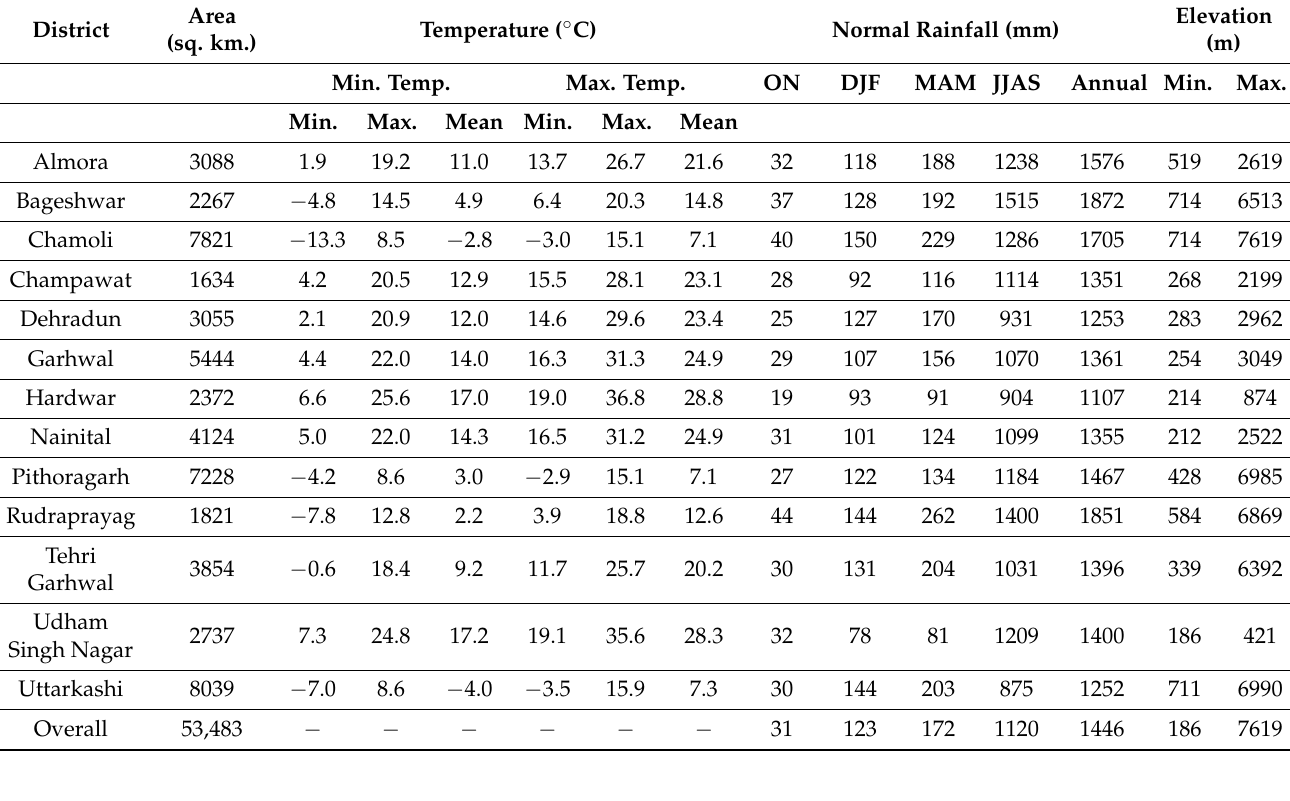
Table 2. The district-wise climatic characteristics and topography of the state. Area (sq. km.)